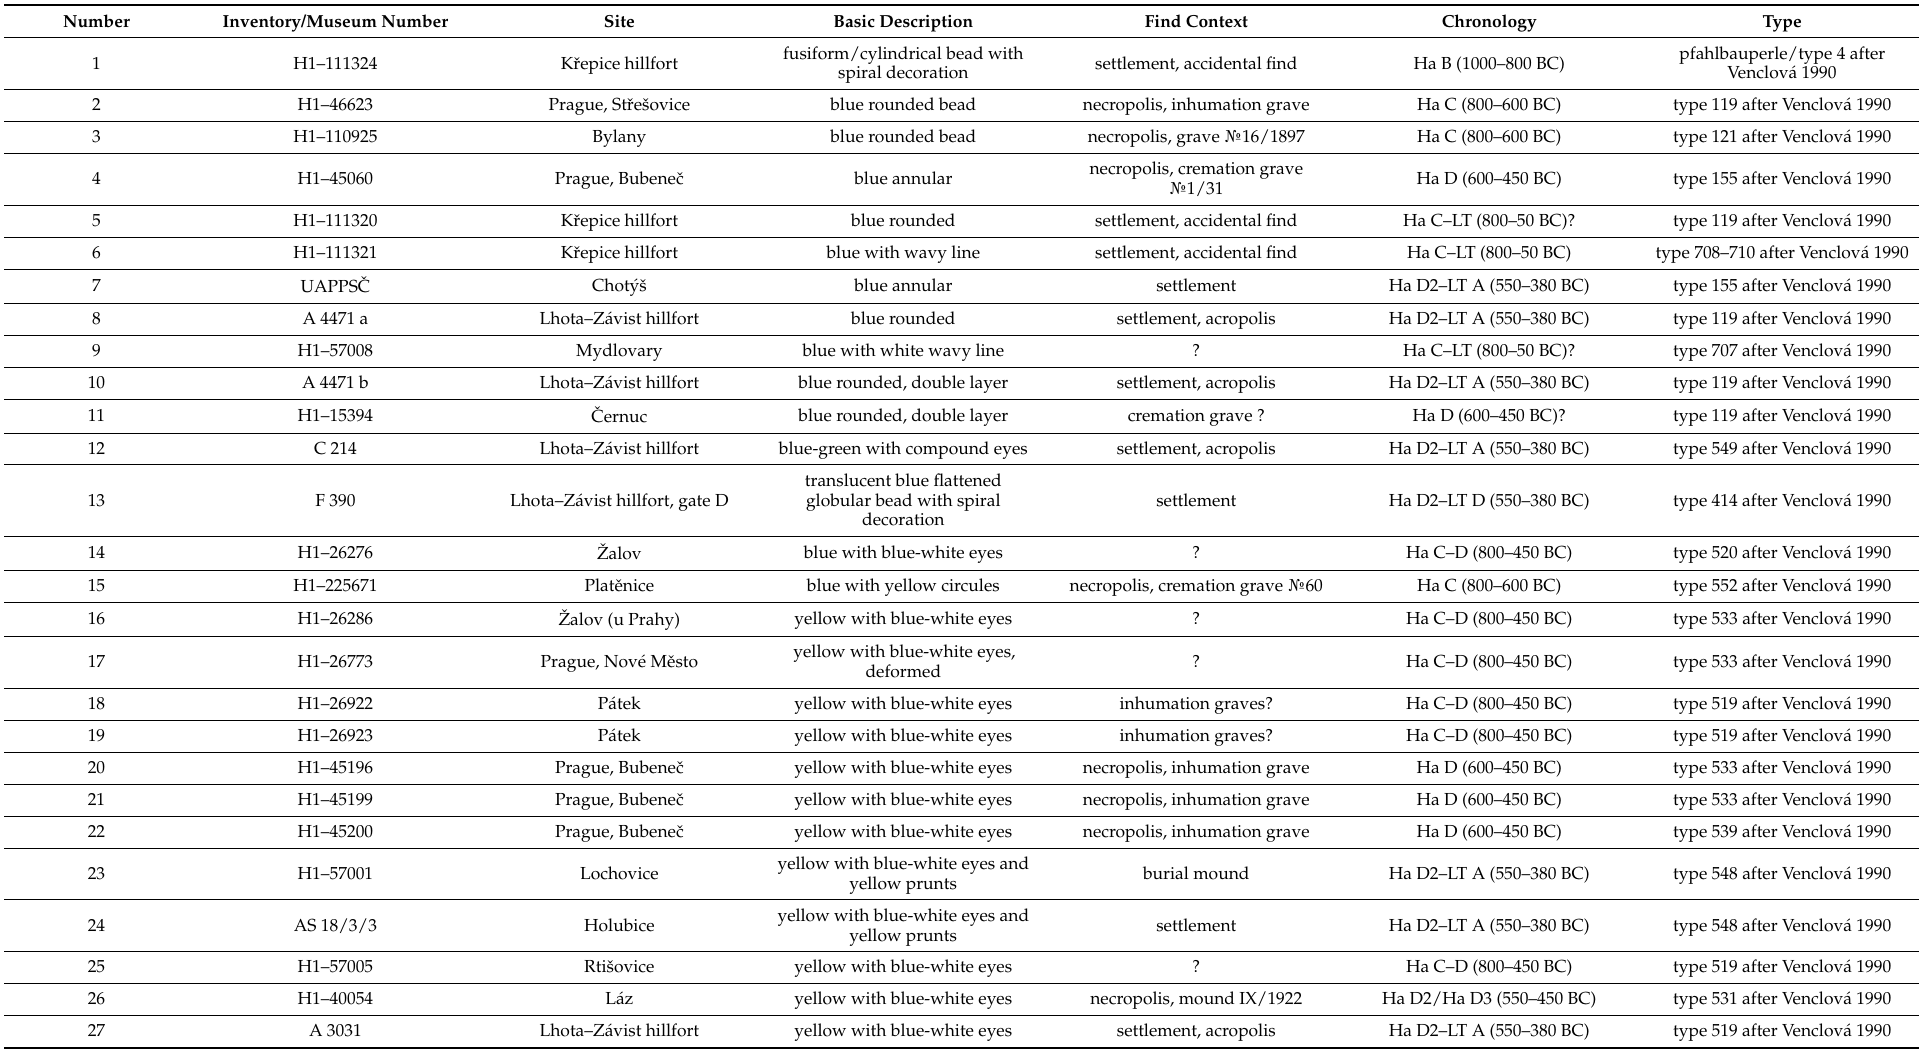
Table 1. List of the analyzed glass